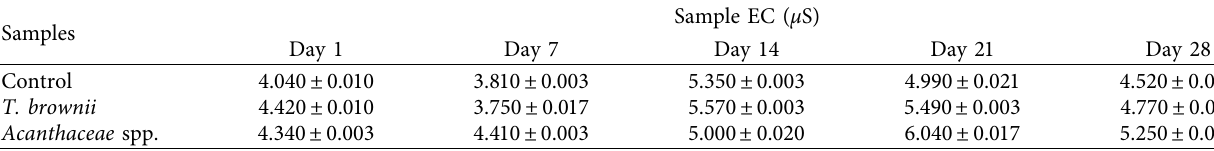
Table 2: Variation in bioslurry EC over a 30-day retention